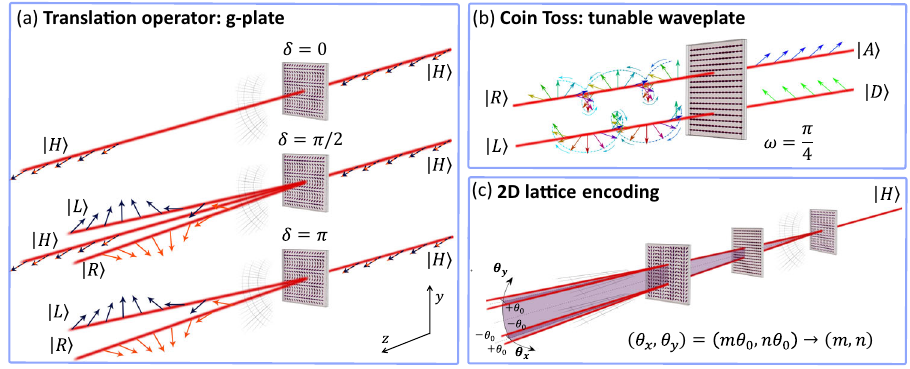
Fig. 2 Encoding of QW operators and walker degree of freedom. a Translation operator: g-plate. The action of a g-plate oriented along y for different values of δ . For δ = 0 the g-plate acts as the identity operator and the light beam is unchanged, while for δ = π the g-plate performs a full conversion. Finally, for all the other values of δ , the g-plates convert only partially the input beam. b Coin toss: tunable waveplate. A waveplate with tunable retardation performs the coin rotation. In the balanced case (shown in the fi gure), the coin toss is performed by